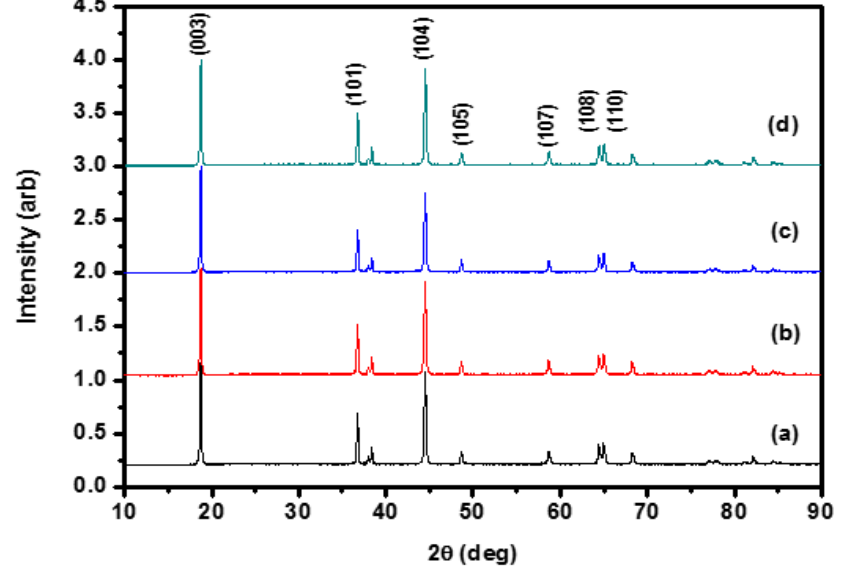
Figure 3. X-ray diffraction patterns of the Li(Ni 0.6 Co 0.2 Mn 0.2 )O 2 samples uncoated and coated with 0.08 wt % Al 2 O 3 annealing at 600 °C for 2, 4, and 10 h, respectively. ( a ) Uncoated; ( b ) annealed at 600 °C for 2 h; ( c ) annealed at 600 °C for 4 h; and ( d ) annealed at 600 °C for 10 h.